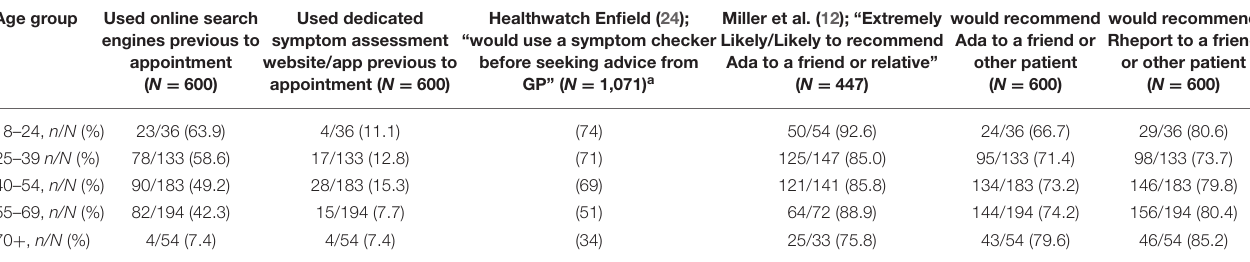
TABLE 3 | Usage of online assessment tools prior to visit and acceptance of DDSS according to respective age groups and in comparison to previous studies. Age group Used online search engines previous